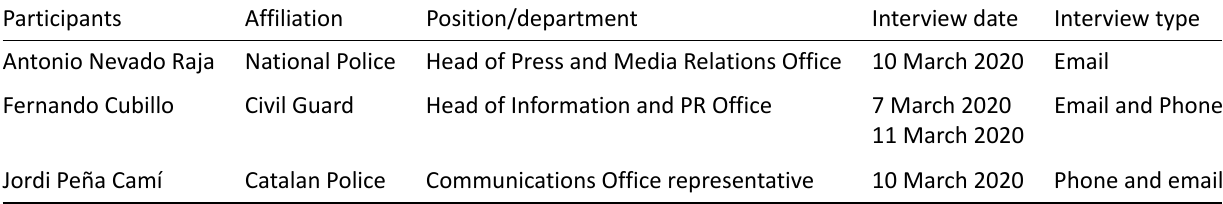
Table 1. Panel of experts representing the Security Forces and Corps. Participants